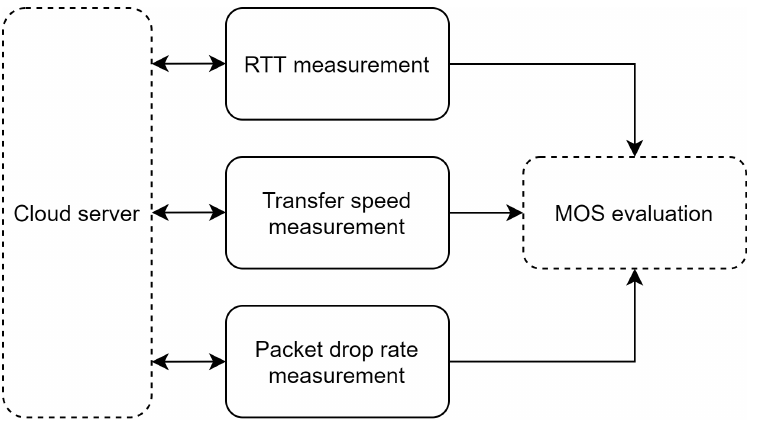
Figure 10. Detailed architecture of the MOS monitor component.